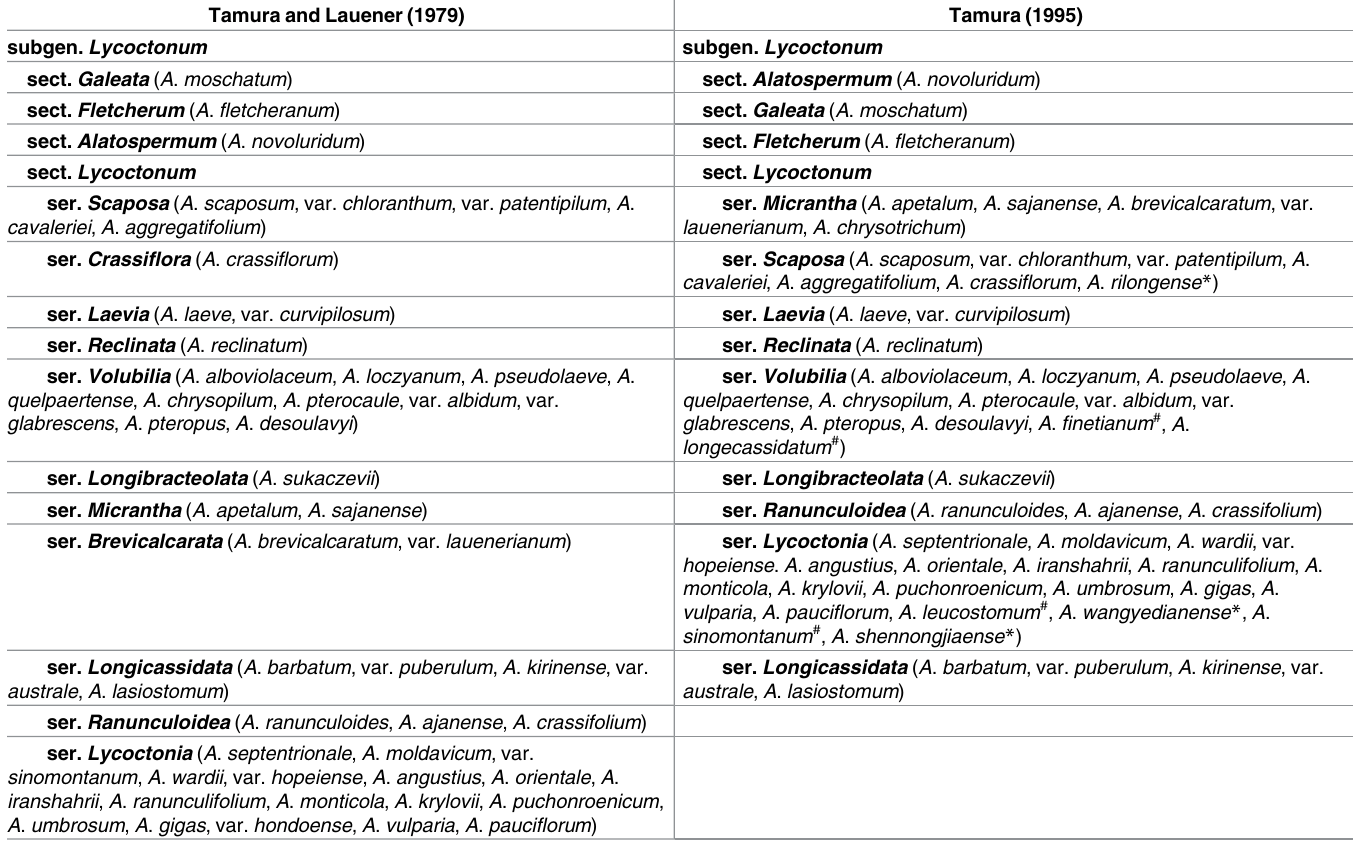
Table 1. Historical classifications of Aconitum subgen. Lycoctonum . Tamura and Lauener